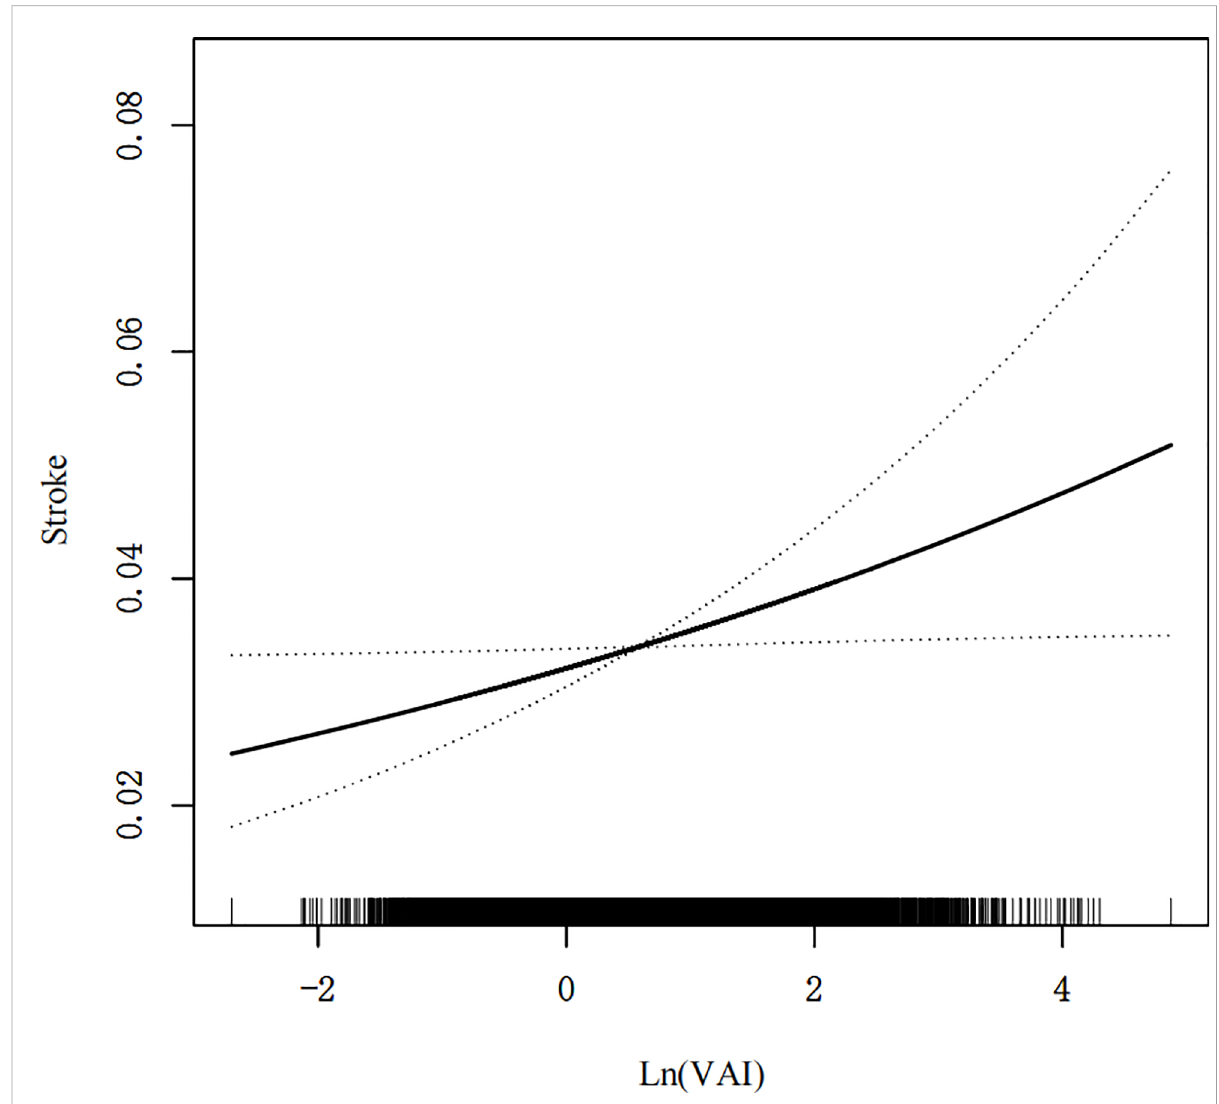
FIGURE 2 Density dose-response relationship between VAI with stroke prevalence. The area between the upper and lower dashed lines is represented as 95% CI. Each point shows the magnitude of the VAI and is connected to form a continuous line. Adjusted for all covariates except effect modi fi